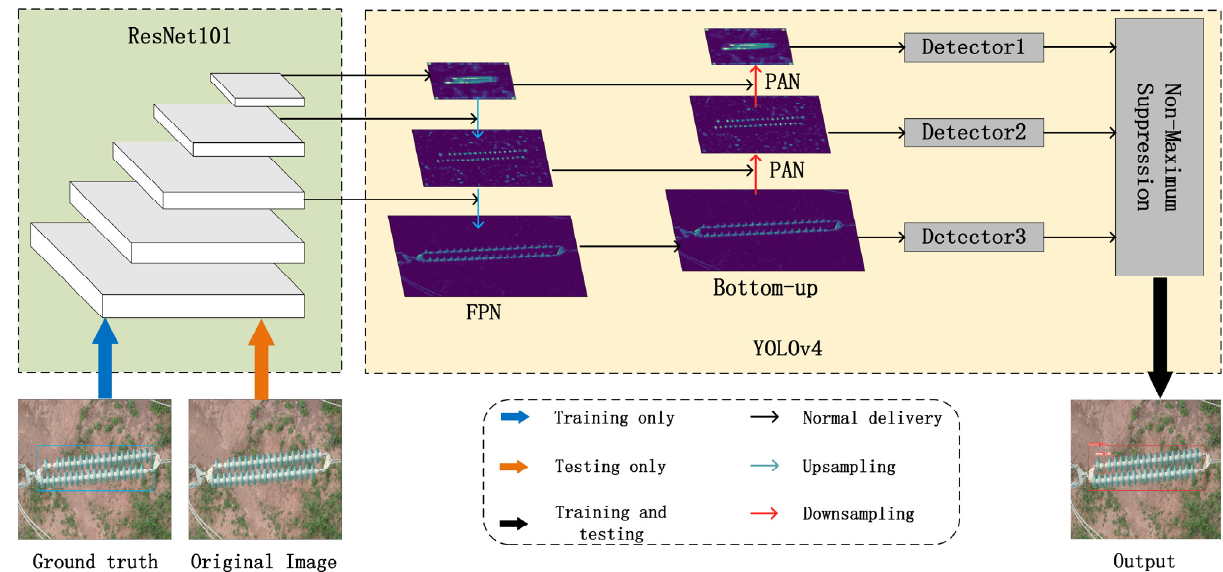
Figure 2. The basic framework of the INSU-YOLO containing two parts: the ResNet101 module and the YOLOv4 module. First, ResNet101 is used to obtain feature maps of different levels of abstraction; FPN and bottom-up structures using PAN in YOLOv4 are then used for feature transfer; finally, we use the detector for classification and box regression to obtain the output image. Table 1. Applied kernels of ResNet101 in INSU-YOLO.